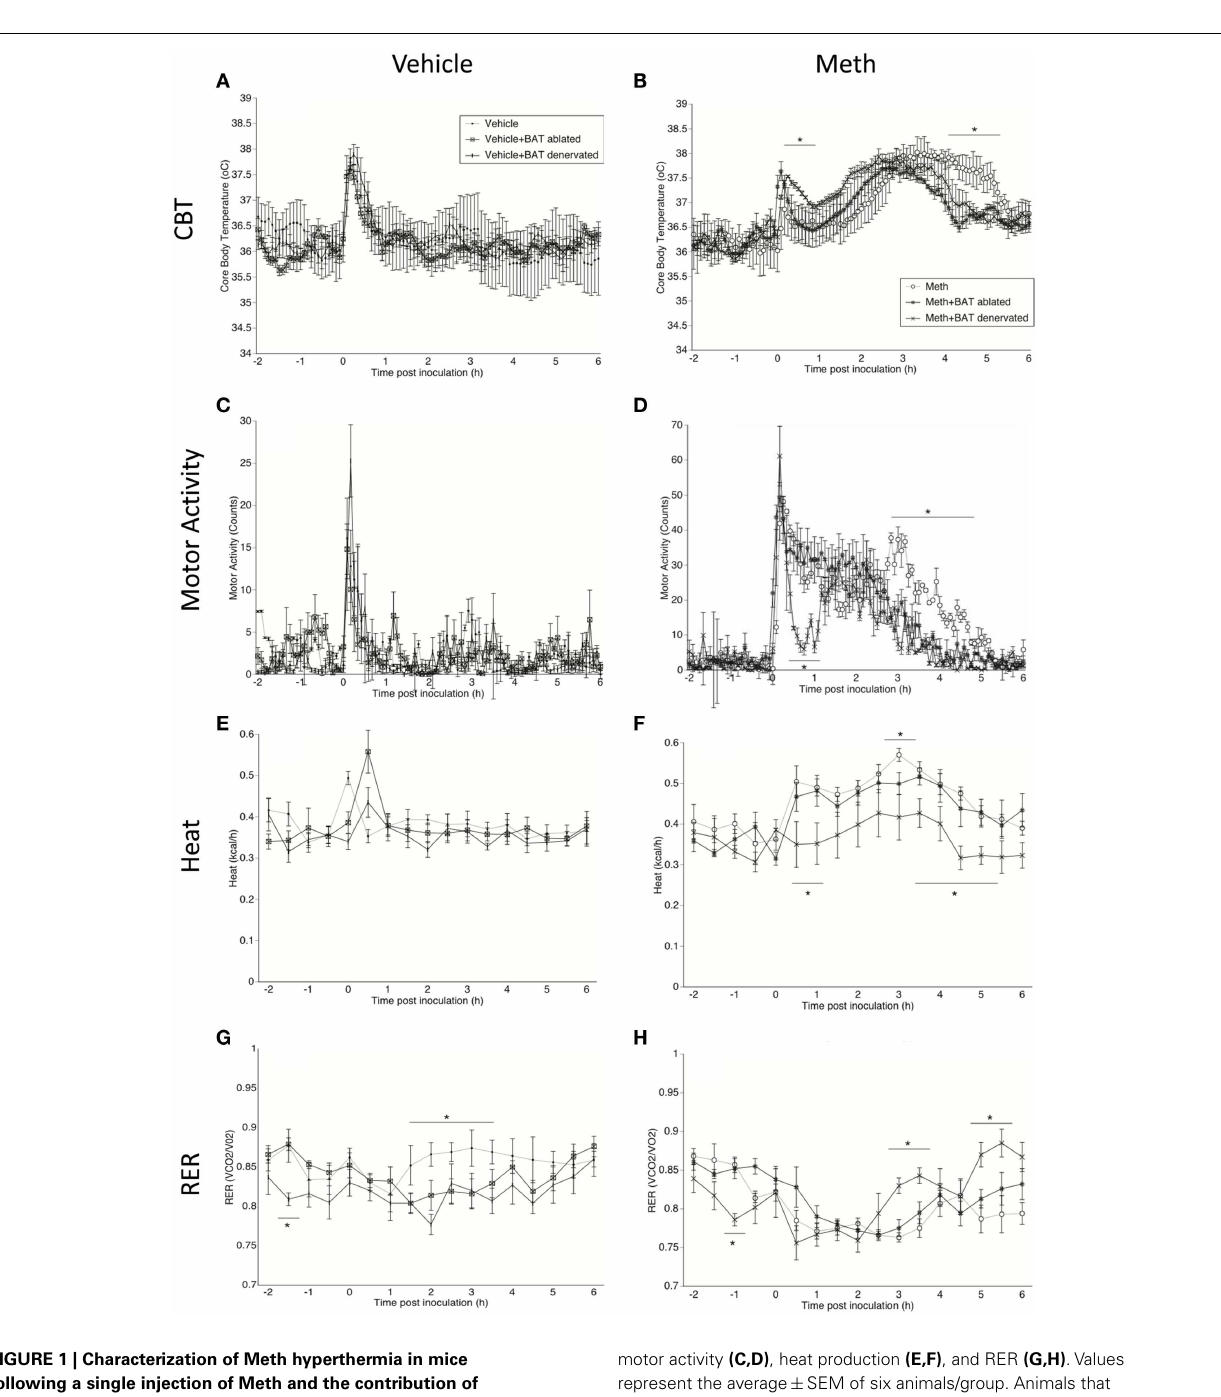
motor activity (C,D) , heat production (E,F) , and RER (G,H) .Values represent the average ± SEM of six animals/group. Animals that had BAT surgically ablated or denervated were compared to sham-operated mice. * p < 0.05, n = 6, Student t -test indicates